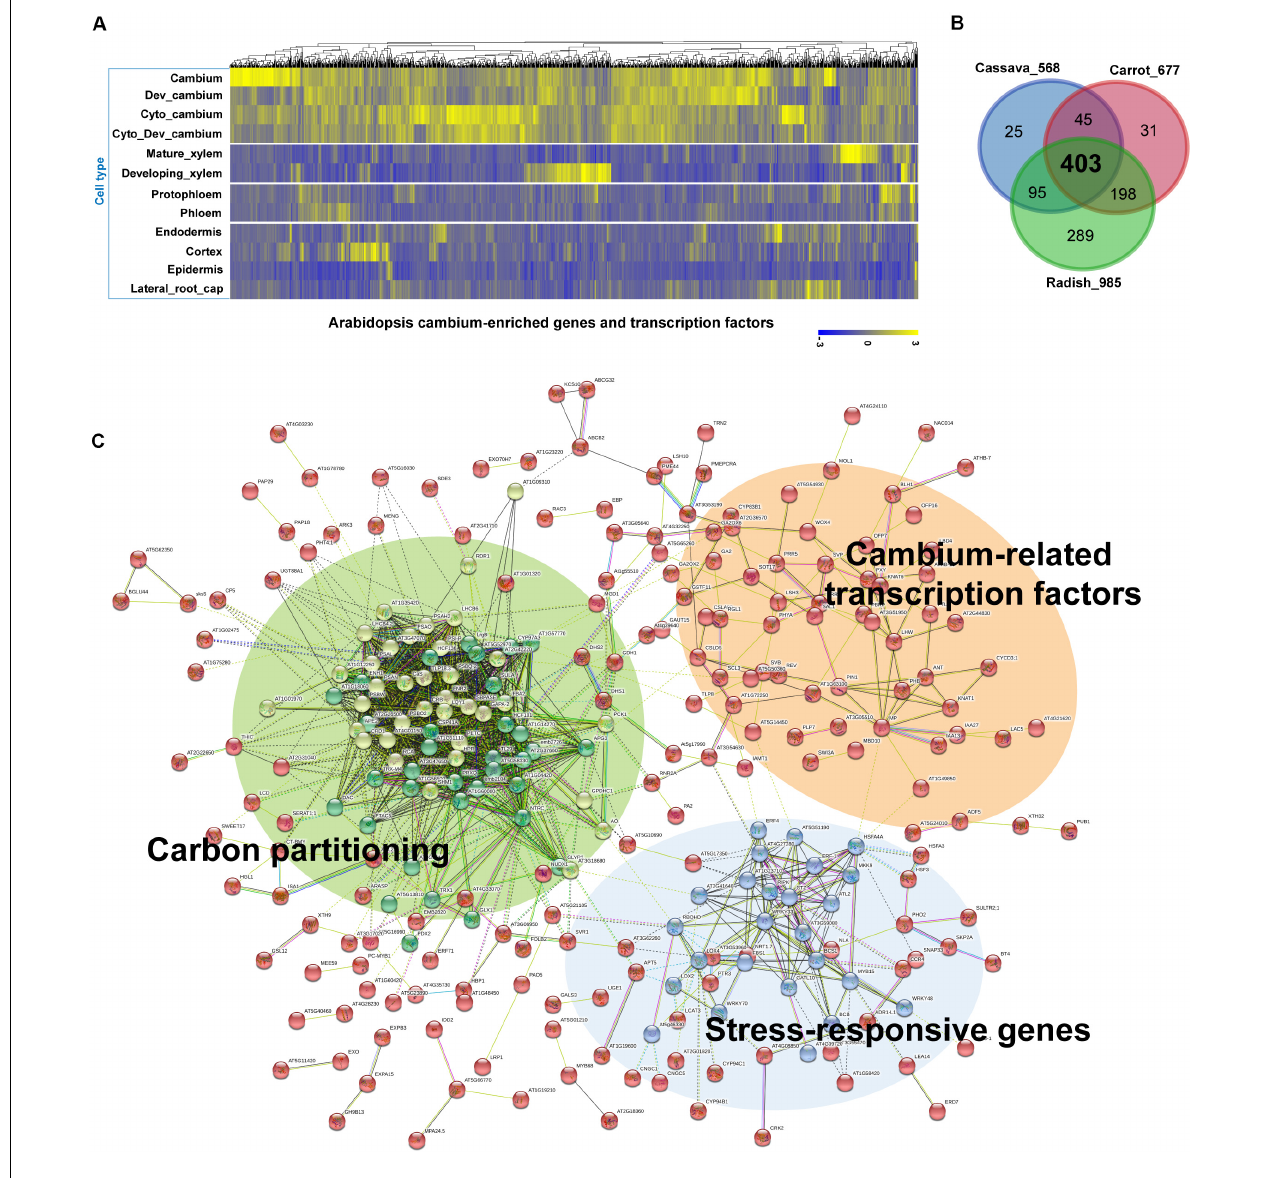
FIGURE 3 | A cross-species comparison of root transcriptome data from major root crops to identify conserved networks critical for storage root growth and yields. (A) Expression of 1,222 cambium-enriched genes in Arabidopsis (Zhang et al., 2019), in selected cell types including cambium, developing cambium (Dev_cambium), cambium after cytokinin treatment (Cyto_cambium), developing cambium after cytokinin treatment (Cyto_ Dev_cambium), mature xylem, developing xylem, protophloem, phloem, endodermis, cortex, epidermis, and lateral root cap. Data were gene-wise normalized, clustered, and plotted using the Pheatmap R package (https://cran.r-project.org/web/packages/pheatmap/). Each vertical line represents one gene. (B) Identification of common DEGs among major root crops. Transcriptome data were obtained for cassava (Wilson et al., 2017), carrot (Machaj et al., 2018), and radish (Hoang et al., 2020). Data were plotted using the Venn tool (http://bioinformatics.psb.ugent.be/webtools/Venn/). (C) Kmeans clustered ( k = 3) network of 403 common DEGs in panel (B) inferred from the STRING database version 11.0 (Szklarczyk et al., 2015). Genes (nodes) are connected by edges, based on a default setting of evidence. For visualization, the unconnected nodes were hidden in the network. A higher resolution of this panel is provided in Supplementary Figure S2